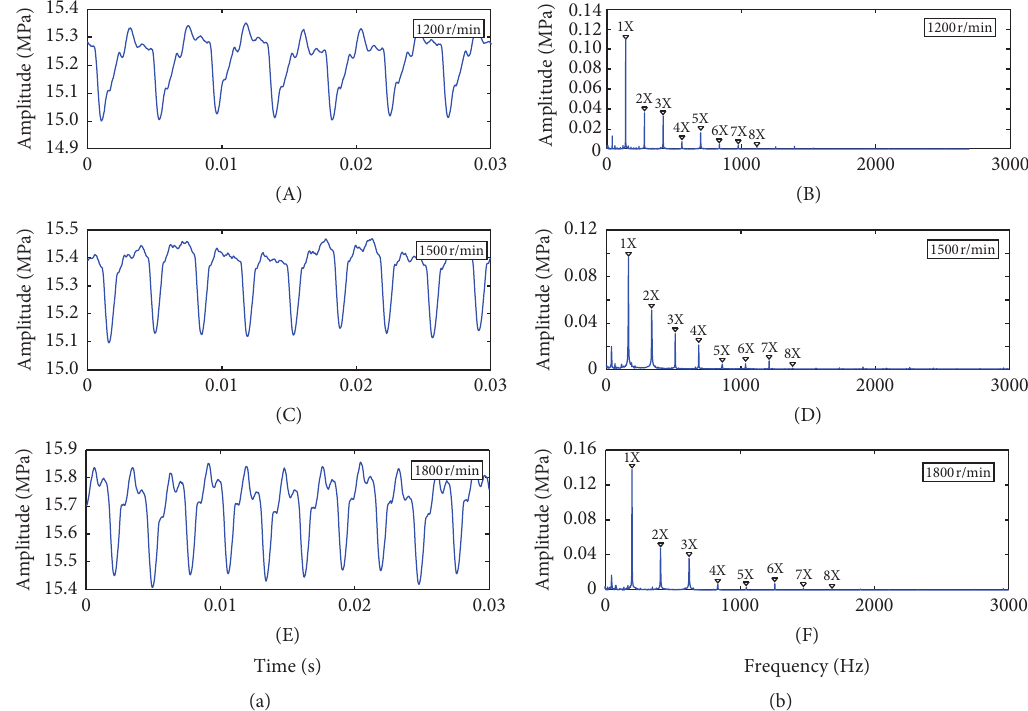
Figure 6: Measurement of fluid pressure fluctuation under various speeds of the pump. (a) Fluid pressure signals in time domain and (b) fluid pressure signals in frequency domain.